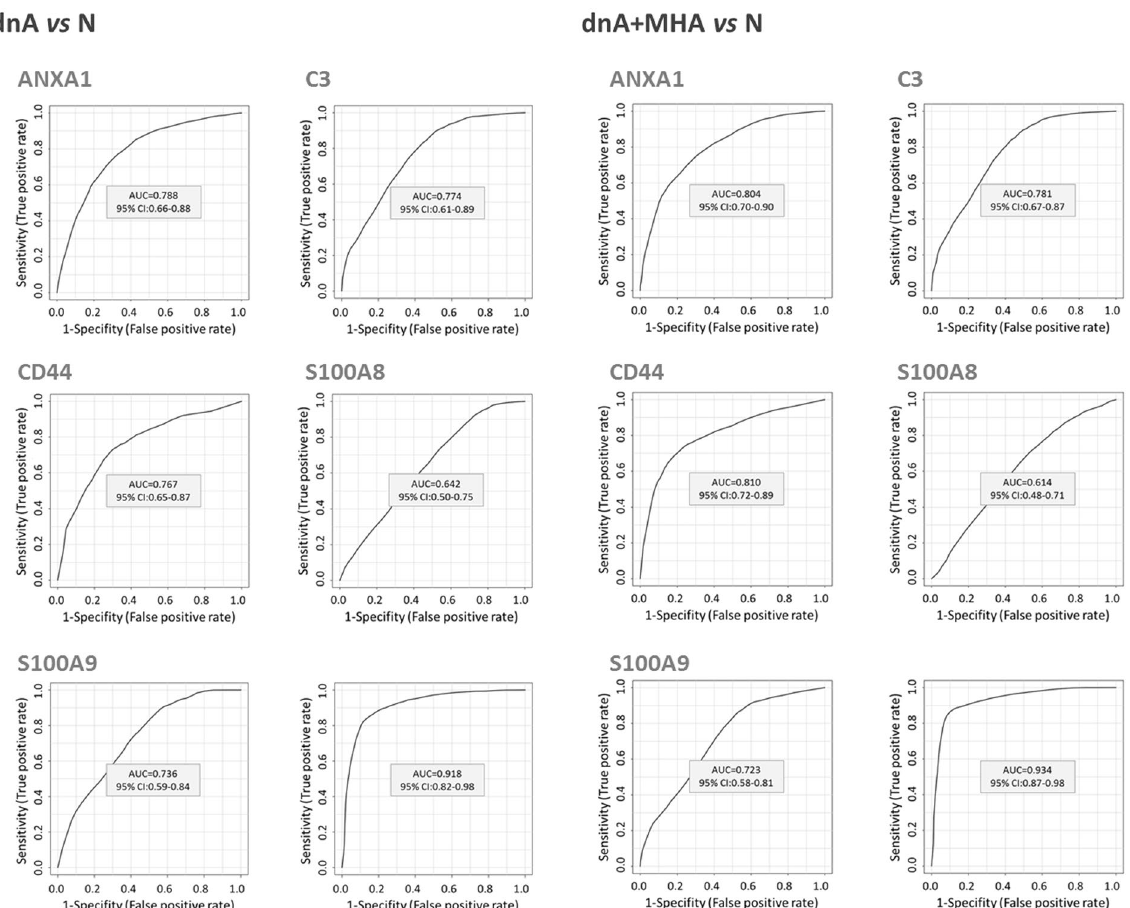
Figure 5. Receiver operating curves (ROC) for the five confirmed proteins are shown, individually and combined. Responses were evaluated by analyzing N vs dnA, and N vs dnA + MHA. N: normoalbuminuria, dnA: de novo albuminuria, MHA: maintained high